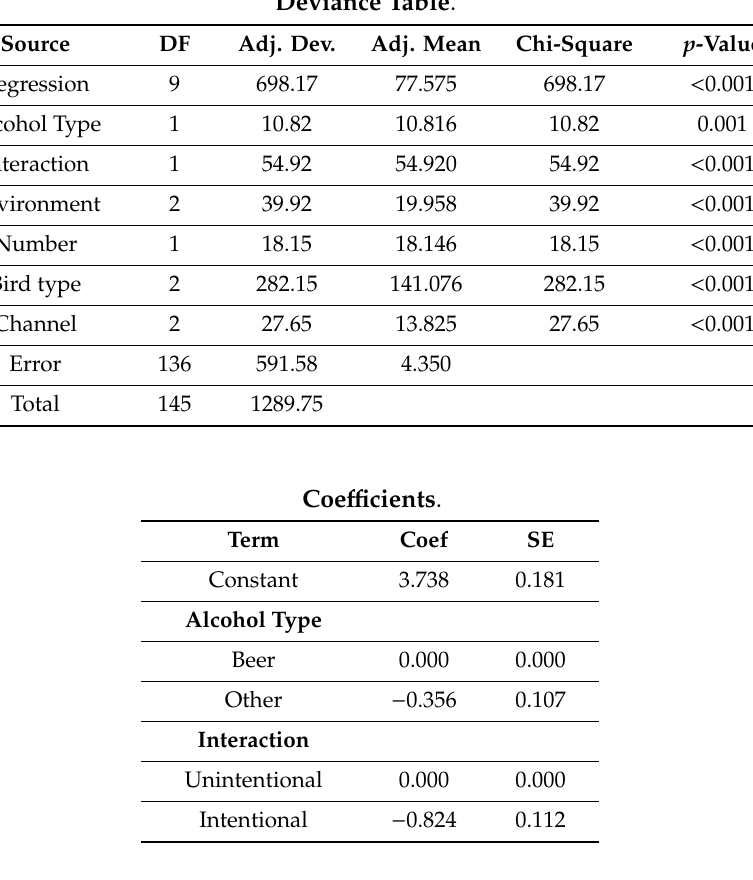
Table 3. Factors a ff ecting human reaction to drinking birds (binary logistic regression of thumbs up / down responses to YouTube videos). Variables included (1) alcohol type (beer or other), (2) interaction with people (unintentional or intentional), (3) habitat (home, restaurant / pub or outdoors), (4) number of birds (one or more), (5) bird type (wild, pet or poultry) and (6) YouTube channel (personal, news or humorous). The coe ffi cients for the first level of each variable are set to